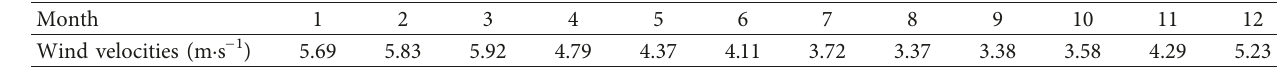
Table 6: Monthly average wind velocities.